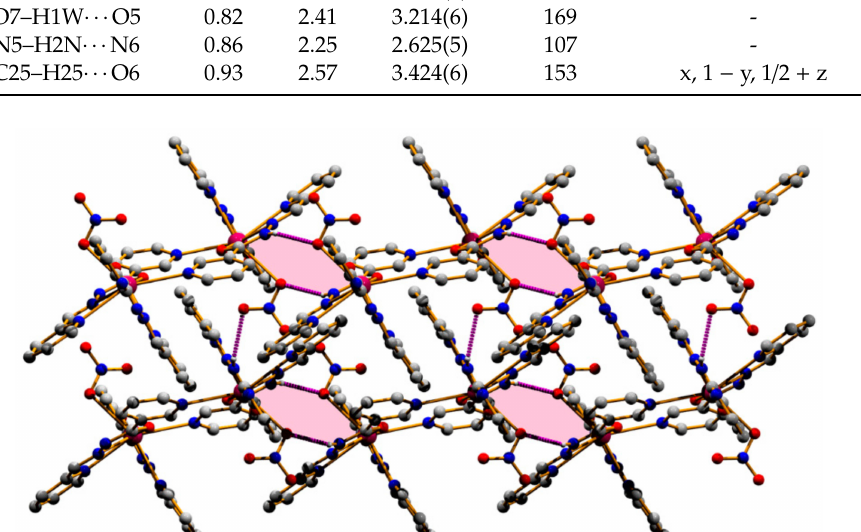
Figure 3. Self-assembled layered framework in ( 1 ) generated by strong N-H ··· O H-bonds in (101) plane.